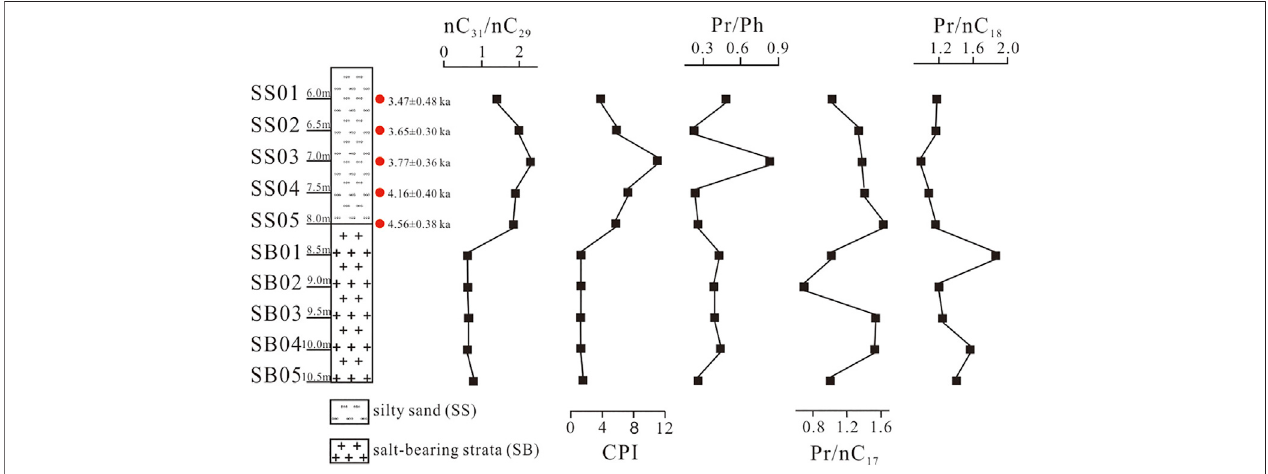
FIGURE 2 | OSL sample site, chronology, CPI, Pr/Ph, Pr/nC 17 , and Pr/nC 18 values of the 10 samples from different strata of the East Taijinar salt lake sediments.